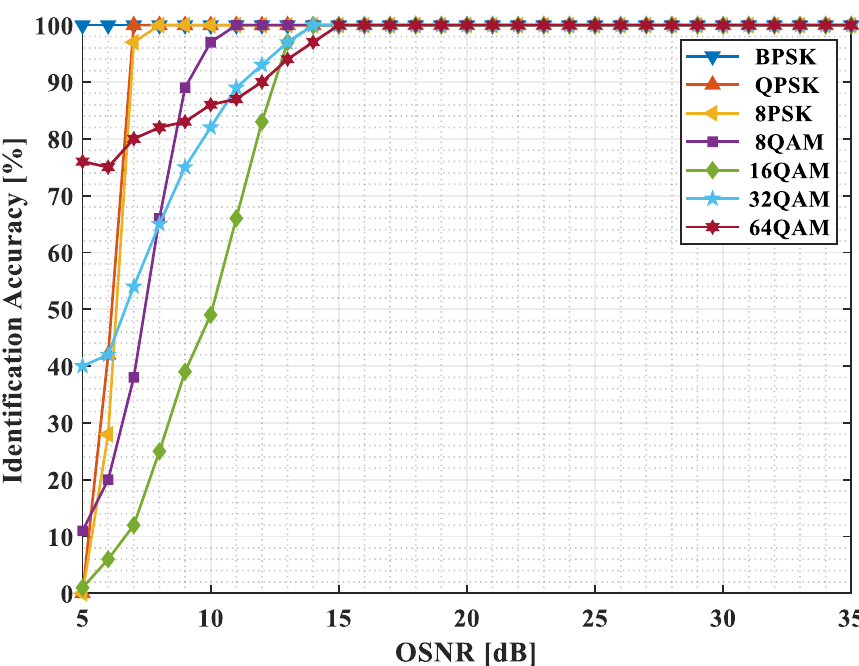
Figure 8. The identification accuracy of the proposed MFI.